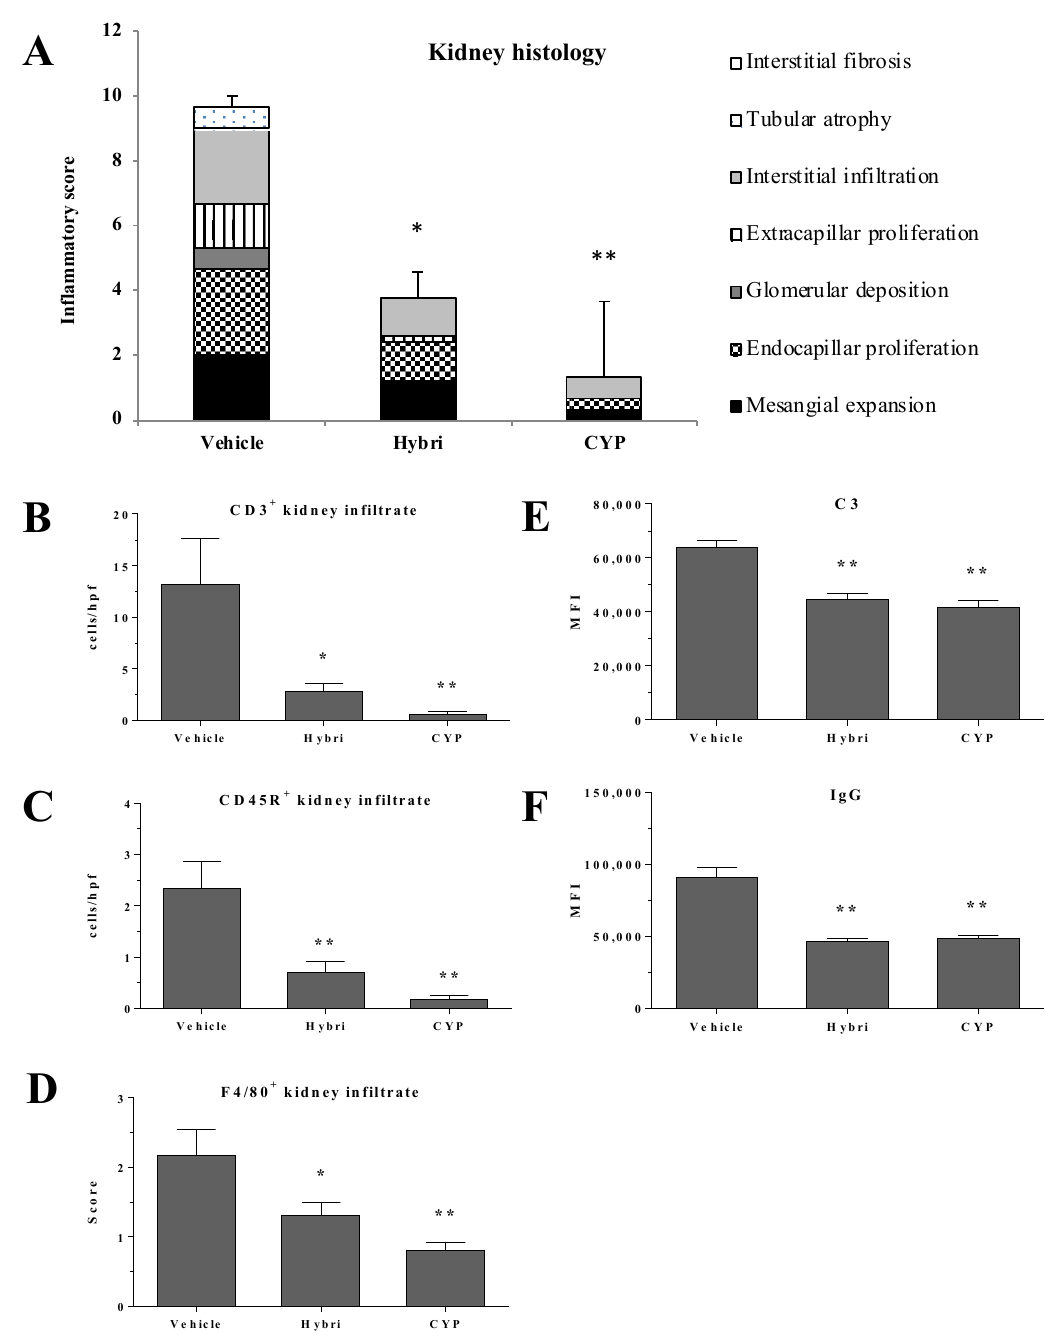
Figure 6. Hybri administration showed an amelioration of kidney morphology and a reduction of effector cell migration and immune deposition in the MRL/lpr mice model. Analysis of samples from surviving mice at the end of the study, at 22 weeks of age. ( A ) Renal histopathology parameters assessed by semiquantitative inflammatory score for hematoxylin and eosin and periodic acid-Schiff staining. Vehicle group: n = 3; Hybri group: n = 5; CYP group: n = 3. ( B ) Number of cells per high-power field (HPF) for renal immunohistochemistry CD3 + and ( C ) CD45R + infiltrate and semiquantitative score for ( D ) F4/80 + infiltrate staining. Vehicle group: n = 5; Hybri group: n = 5; CYP group: n = 6. Mean fluorescence intensity for ( E ) glomerular C3 and ( F ) IgG deposition, measured under a confocal microscope. Vehicle group: n = 5; Hybri group: n = 5; CYP group: n = 6. Data are expressed as mean ± S.E.M. * p < 0.05 versus vehicle; ** p < 0.01 versus vehicle.